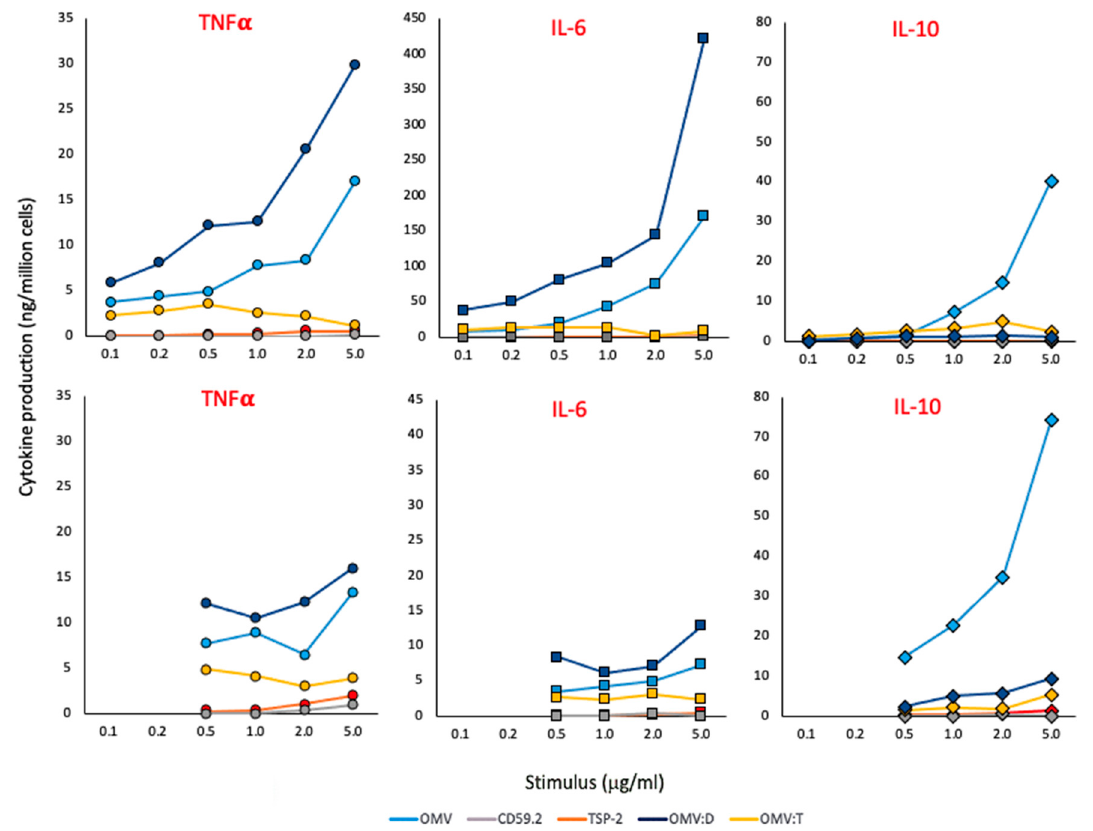
Figure 2. Primary response of human monocytes and macrophages to S. mansoni antigens. The production of TNF α (left panels, round symbols), IL-6 (center panels, square symbols) and IL-10 (right panels, diamond symbols) was assessed in human fresh blood monocytes (upper panels) and monocyte-derived macrophages (lower panels) stimulated for 24 h with increasing concentrations of unconjugated OMV (light blue), rSmCD59.2 (gray), rSmTSP-2 (red), OMV:D (dark blue), or OMV:T (yellow). The negative and positive controls (culture medium alone and LPS 10 ng/mL) are the following: TNF α in monocytes 0.03 and 2.23 ng/10 6 cells; TNF α in macrophages 0.00 and 3.06; IL-6 in monocytes 0.04 and 5.00; IL-6 in macrophages 0.00 and 1.84; IL-10 in monocytes 0.00 and 0.16; IL-10 in macrophages 0.02 and 0.30. Data are from one donor of 2–4 tested (data from other donors are reported in the Supplementary Table S1). The SD of technical replicates was always <10% and is not reported. Statistical significance is reported in the Supplementary Table S2.